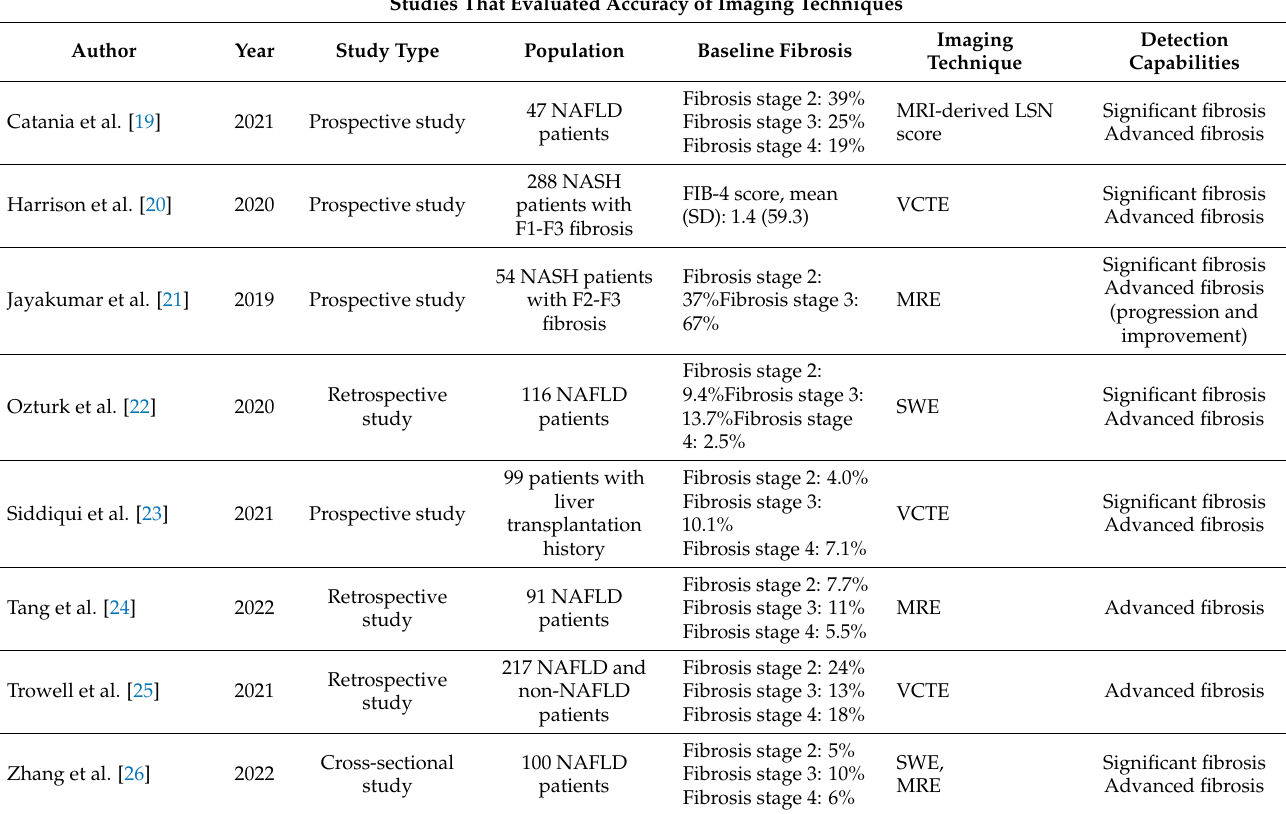
Table 3. Characteristics of included studies.